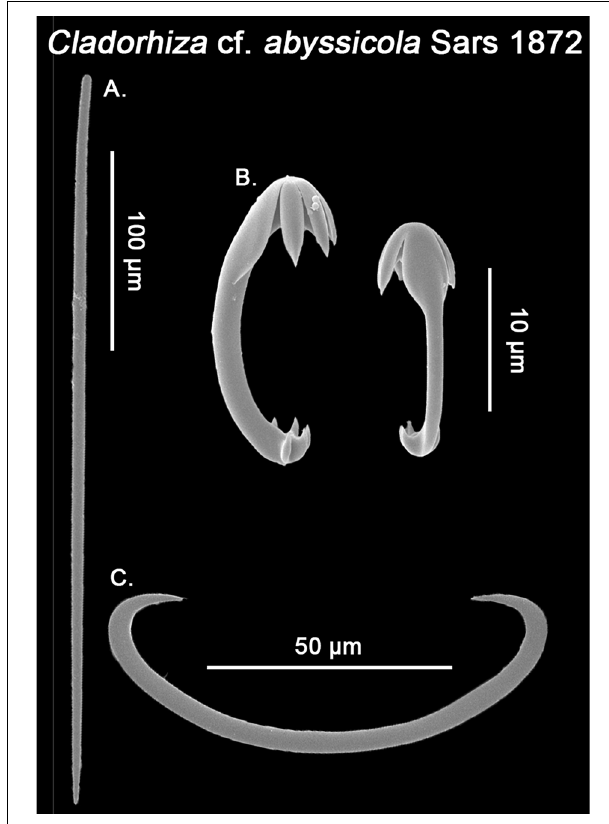
FIGURE 7 | SEM imagining of Cladorhiza cf. abyssicola spicular set. (A) Mycalostyes; (B) Anchorate anisochelae; (C) Sigma. Scale bar for (A) 100 µ m; scale bar for (B) 10 µ m; and scale bar for (C) 50 µ m.